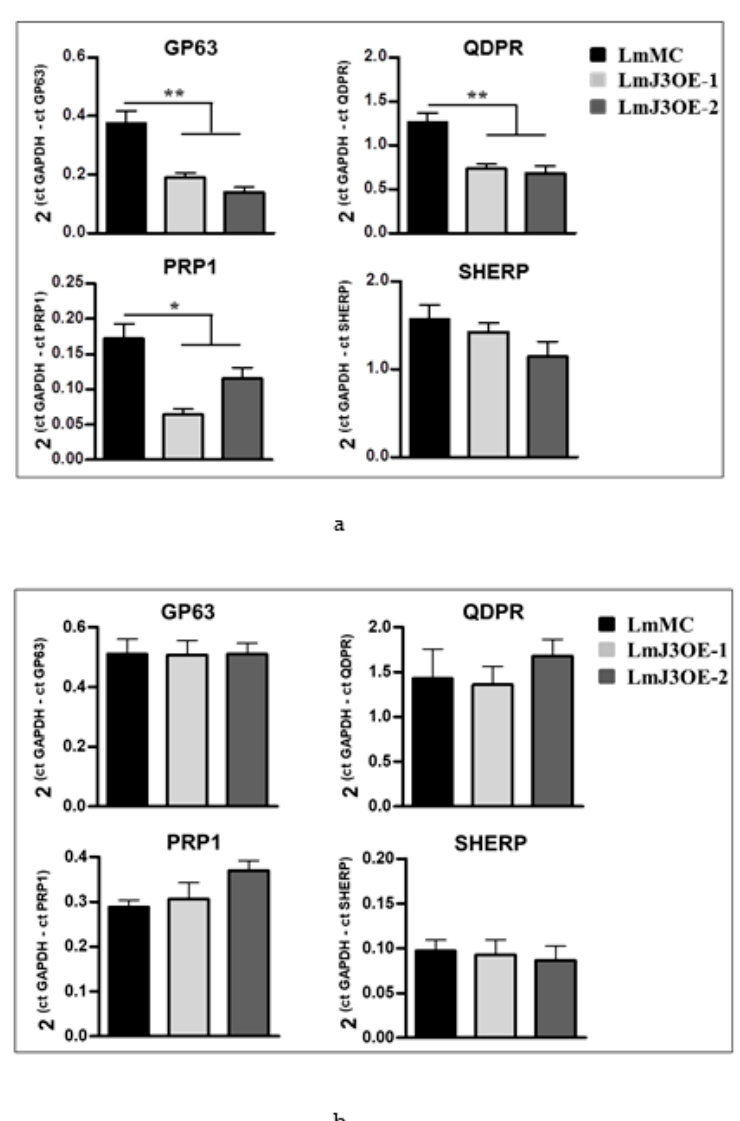
Figure 2. Expression profile of genes involved in the infectivity of LmjF.22.0810-overexpressing parasites compared to control. The mRNA expression levels of the zinc–metalloprotease GP63 ; quinonoid–dihydropteridine reductase ( QDPR ); the ATP-binding cassette transporter PRP1 ; and the small, hydrophilic, endoplasmic reticulum-associated protein ( SHERP ) were determined by qPCR in the ( a ) metacyclic promastigote and ( b ) amastigote forms of the three parasite strains, overexpressing (LmJ3OE-1 and LmJ3OE-2) or not overexpressing (LmMC) LmjF.22.0810 kinase. Bars represent the means ( ± SD) from three independent experiments (* p < 0.05, ** p <